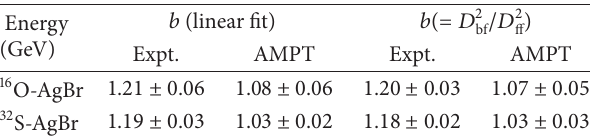
Table 1: Values of correlation strength, 𝑏 , and 𝜒 2 /D.F. for the exper- imental and AMPT event samples at different projectile